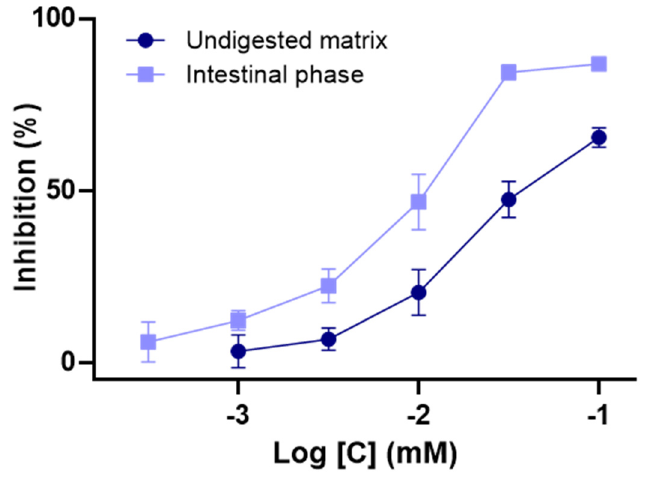
Figure 4. Influence of in vitro digestion on the α -glucosidase inhibition activity of cyanidin-3- O - glucoside. Data are indicated as means ± SEM ( n = 3). All results are expressed as percentages.